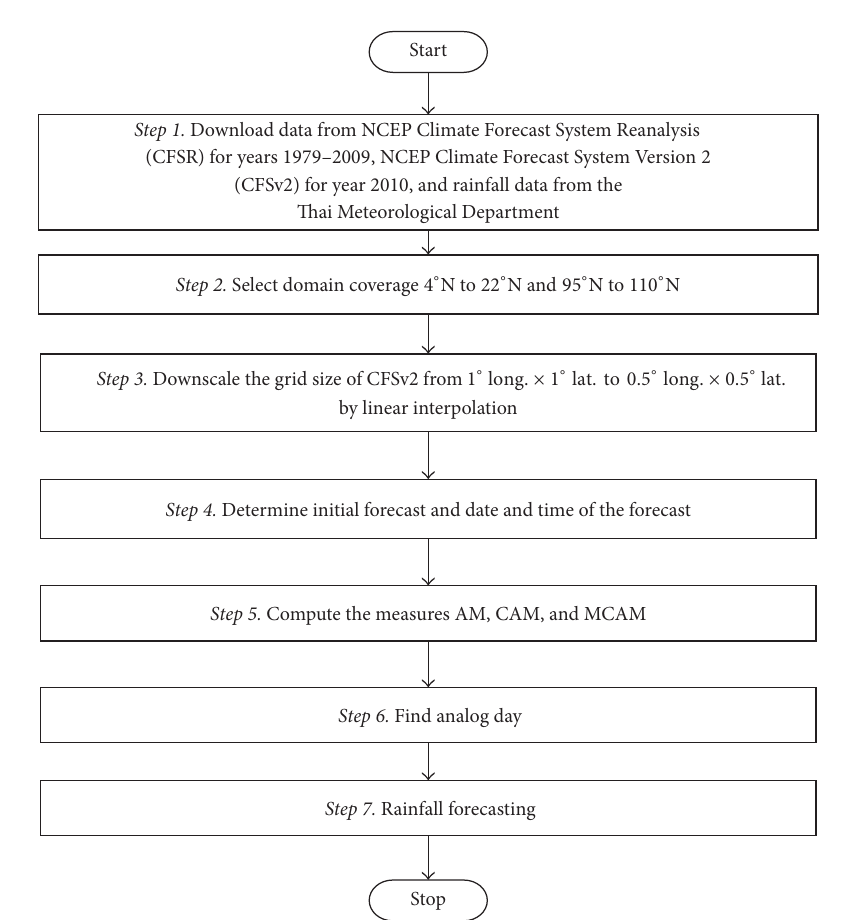
Figure 4: Flow chart showing the steps of simulation for AM, CAM, and MCAM at 0000, 0600, 1200, and 1800